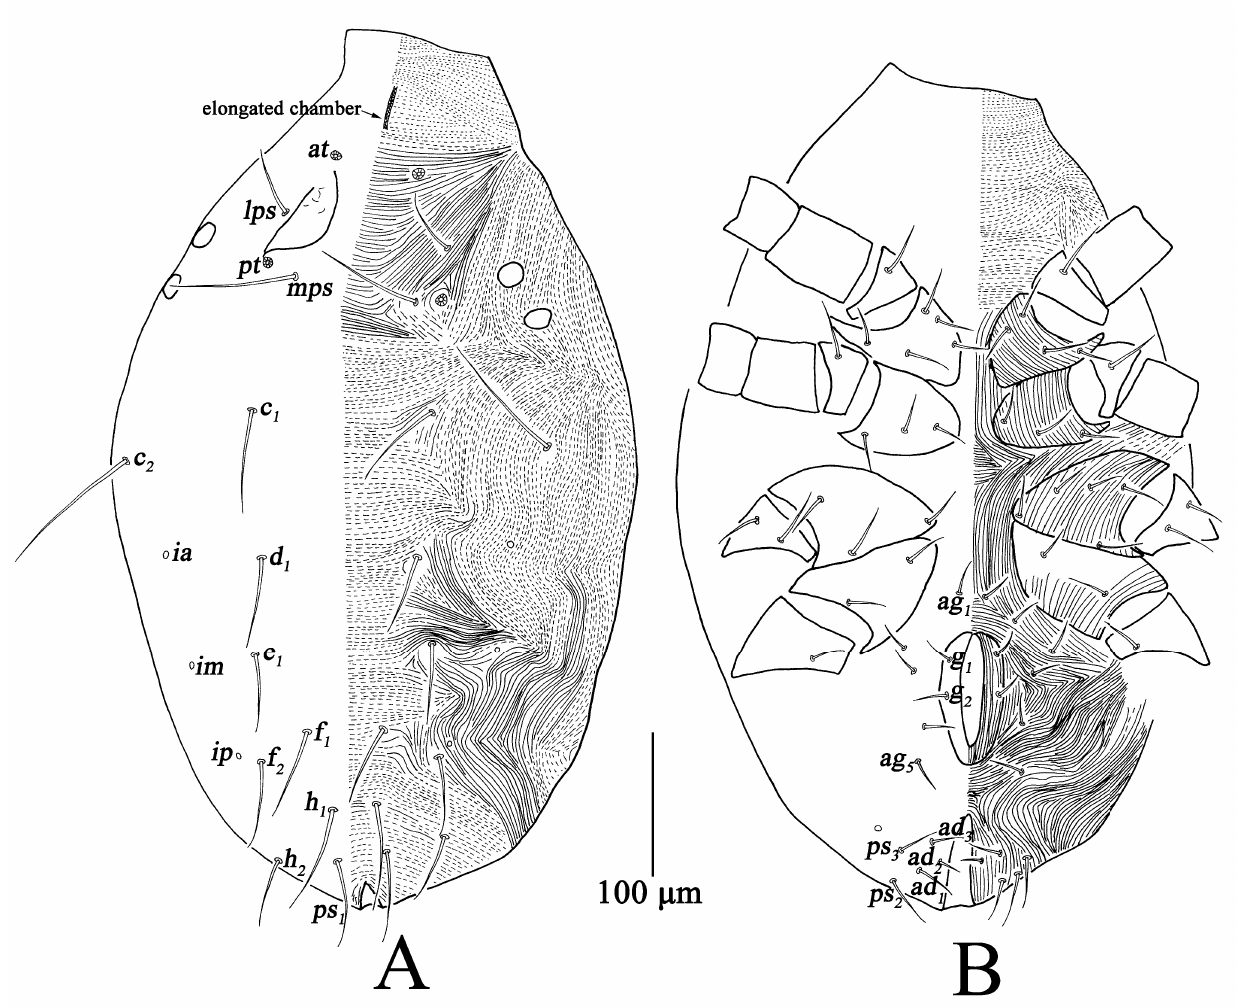
Figure 8. Bdella muscorum , deutonymph: ( A ) Dorsal view of idiosoma; ( B ) Ventral view of idiosoma.